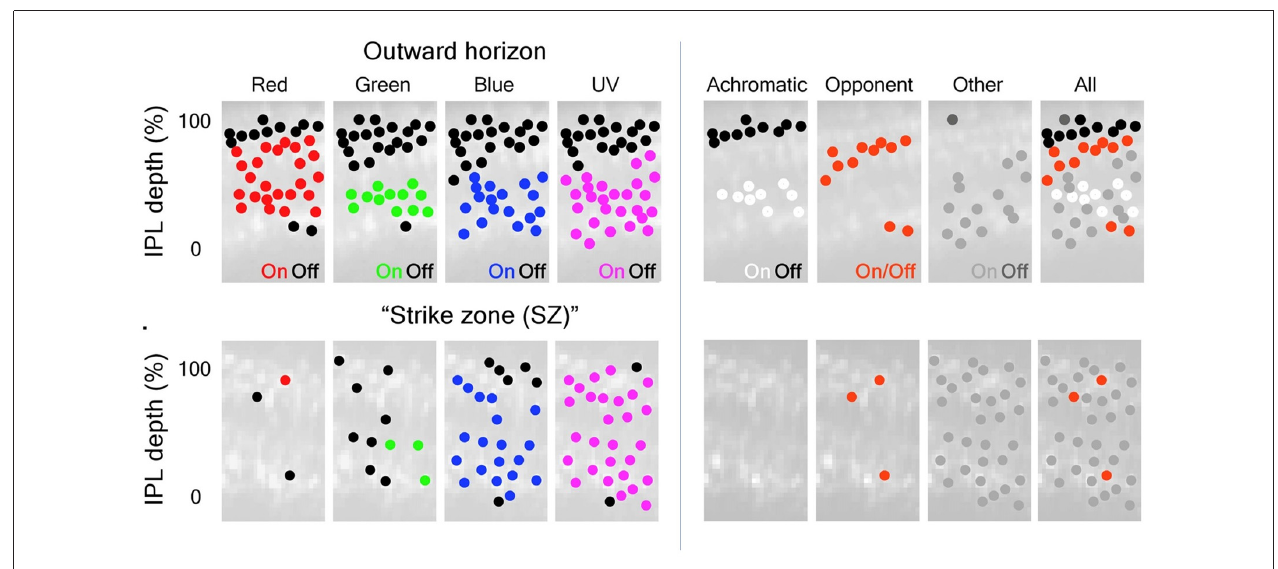
FIGURE 5 | Color inputs to inner retina are segregated in the IPL. BC terminals in the larval zebrafish IPL can be segregated based on the spectral inputs they respond to across the visual scene. (Left) BC-terminal excitation by R, G, B, and UV stimuli are represented as red, green, blue and magenta dots located throughout the IPL; inhibitory responses are represented as black dots. The distribution of ON-responses varies based on the spectral stimulus and which part of the visual scene (outer horizon vs. “strike zone (SZ)”) is being viewed. The “SZ” represents looking forward and upward at prey items. (Right) Subsequent classification of the different spectral inputs from BCs into the IPL identified achromatic and color-opponent regions in this synaptic layer that were most evident outside the “SZ”. For the right panels: black dots = achromatic OFF-responses, white dots = achromatic ON-responses, red dots = color-opponent responses, gray dots = “other” (taken from Figure 3, Zimmermann et al.,